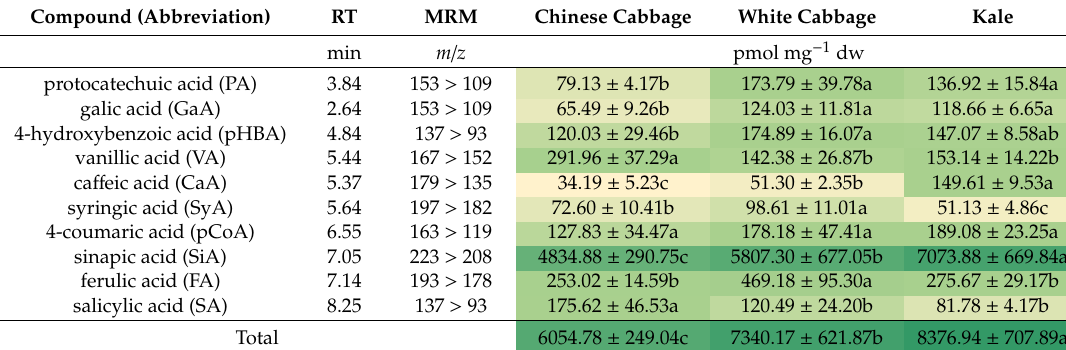
Table 2. List of determined phenolic acids by UPLC–MS / MS, their retention times (RT) and multiple reaction monitoring transition MRM. Total levels of particular phenolic acids were expressed (pmol mg − 1 dw) in untreated seedlings of Chinese cabbage, white cabbage, and kale. Color gradation from light yellow to dark green comparatively represents values among species from the lowest to the highest.